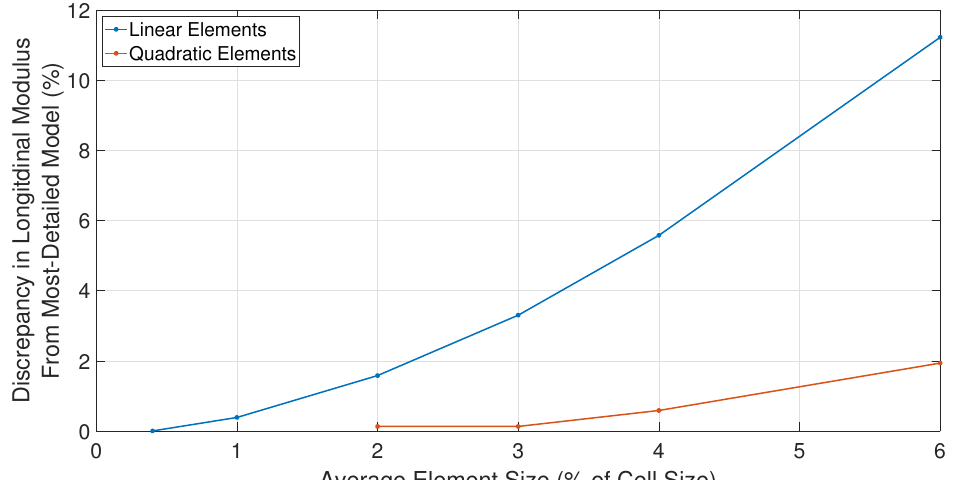
Figure 8. Mesh convergence data.